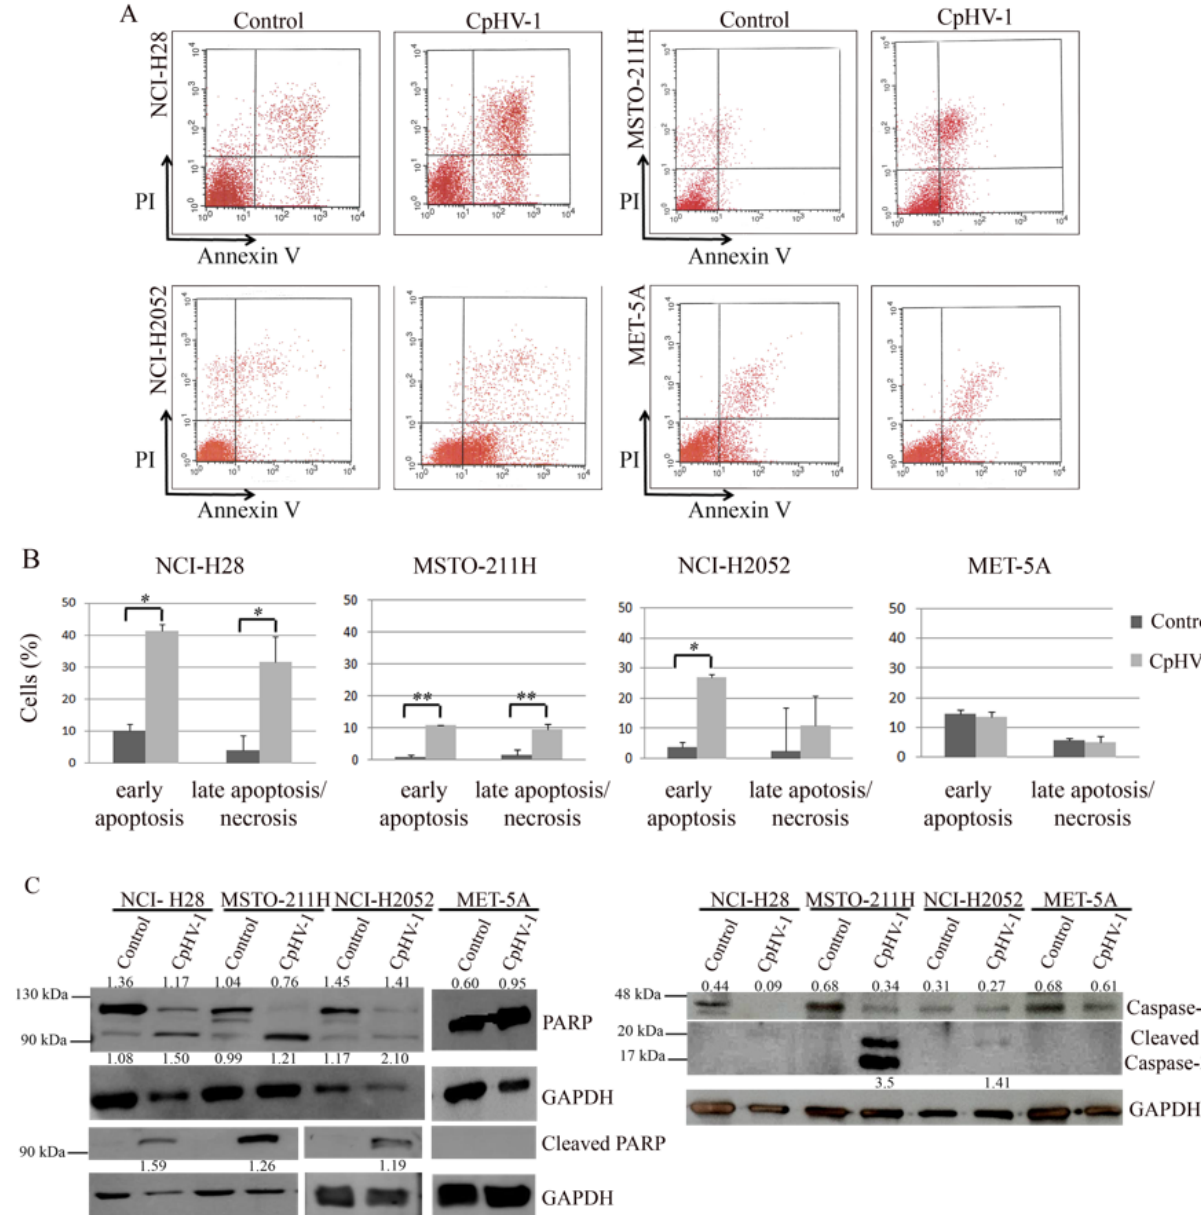
Figure 2. Apoptosis induction in mesothelioma cells infected with caprine herpesvirus 1 (CpHV-1). ( A ) FACS analysis to investigate apoptosis by cell staining with Annexin V-FITC and propidium iodide (PI) in NCI-H28, MSTO-211H, NCI-H2052, and MET-5A cells 72 h post-infection with 5 MOI (multiplicity of infection) of CpHV-1. A representative plot, based on at least two independent experiments, showing early apoptosis (annexin V positivity and PI negativity) and late apoptosis/necrosis (positivity to both annexin V and PI), is reported. ( B ) Histograms reporting the means with standard deviations of at least two independent Annexin V-FITC and PI experiments. Statistically significant differences were evaluated by one-way repeated measures ANOVA with Bonferroni post-test and indicated as follows: * p < 0.05; ** p < 0.01. ( C ) Western blot analysis of poly (ADP-ribose) polymerase (PARP) and Caspase-3 in NCI-H28, MSTO-211H, NCI-H2052, and MET-5A treated, as reported above. The anti-PARP and anti-caspase-3 antibodies detect both the full-length proteins and the active cleaved form. For caspase-3, the full-length protein and the cleaved form are shown separately at different exposure times (the full-length protein bands are shown at a shorter exposure time because they become overexposed at the time necessary for cleaved caspase-3 bands to appear). An antibody specifically recognizing cleaved PARP was also used. An anti-GAPDH antibody was used for loading control. Band densitometry values indicate the levels of both full-length and cleaved forms of PARP and caspase-3 normalized to GAPDH levels.